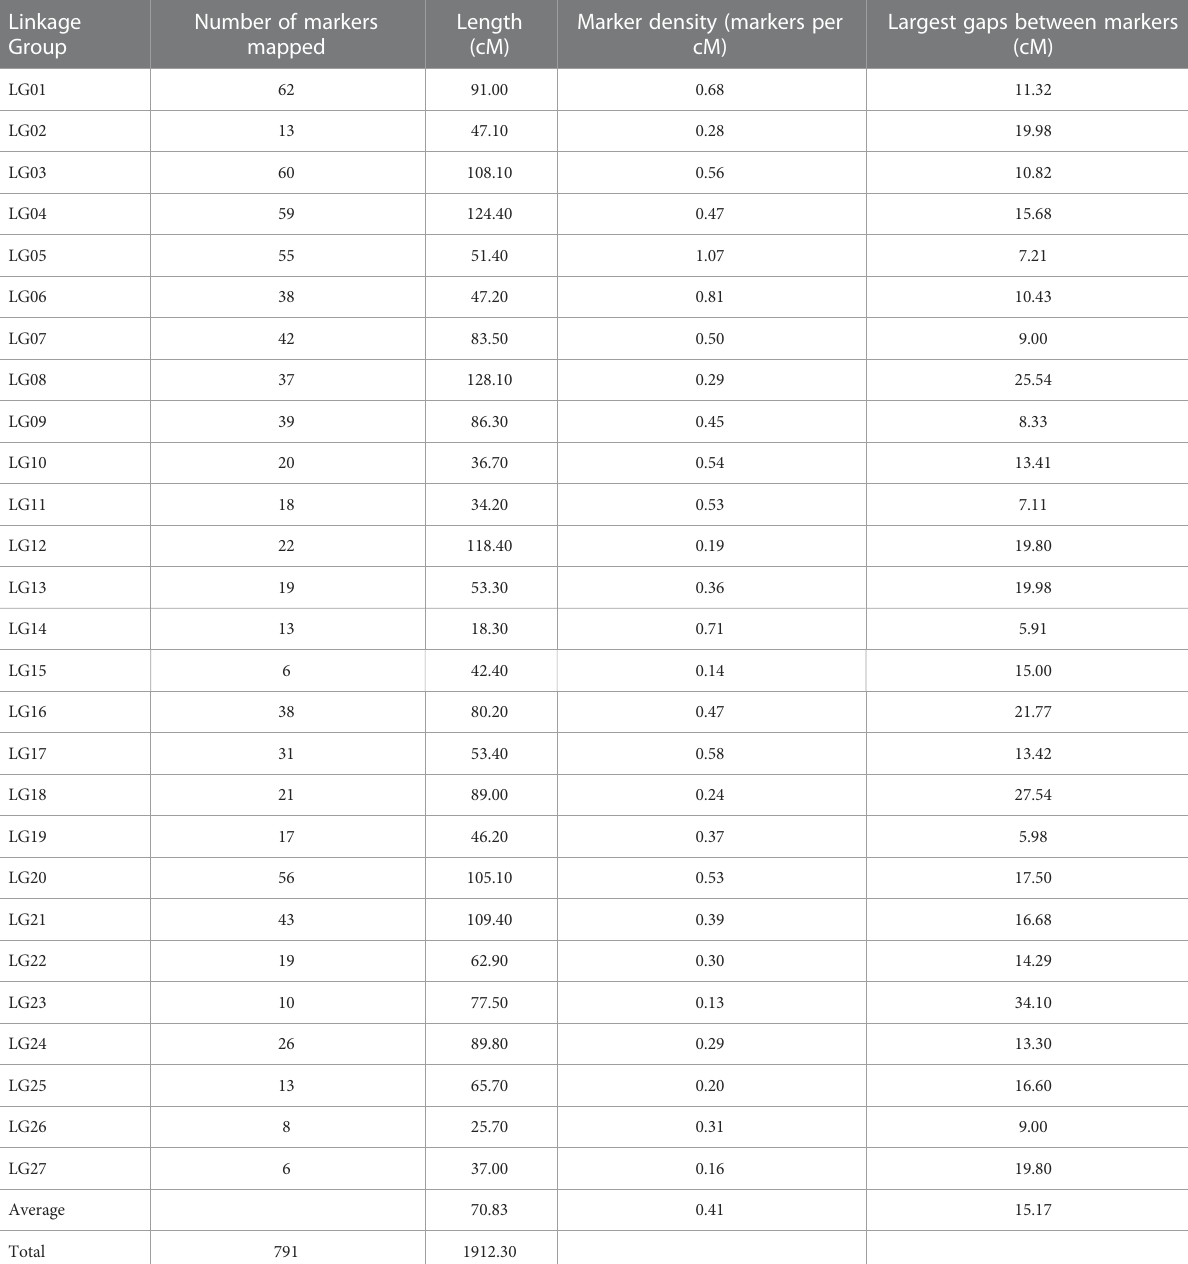
TABLE 1 Description of Gerbera genetic linkage groups constructed using SNPs discovered by genotyping by sequencing of a biparental mapping population (F 1